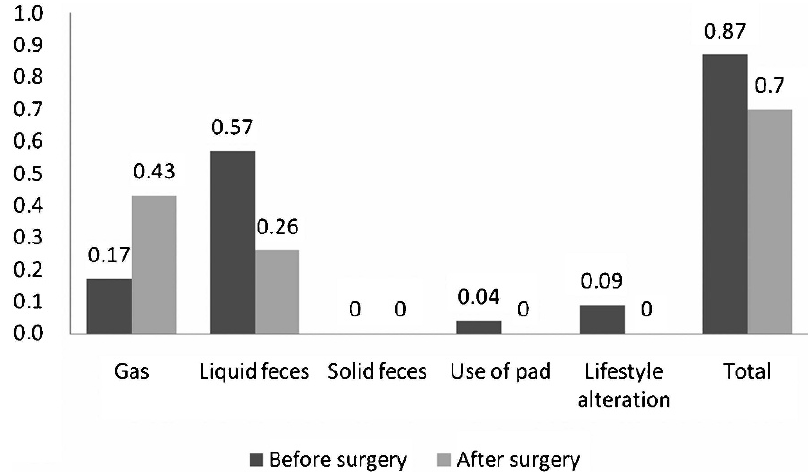
Figure 1 - Comparative analyses of Cleveland Clinic Anal Incontinence Index scores before and after perineal